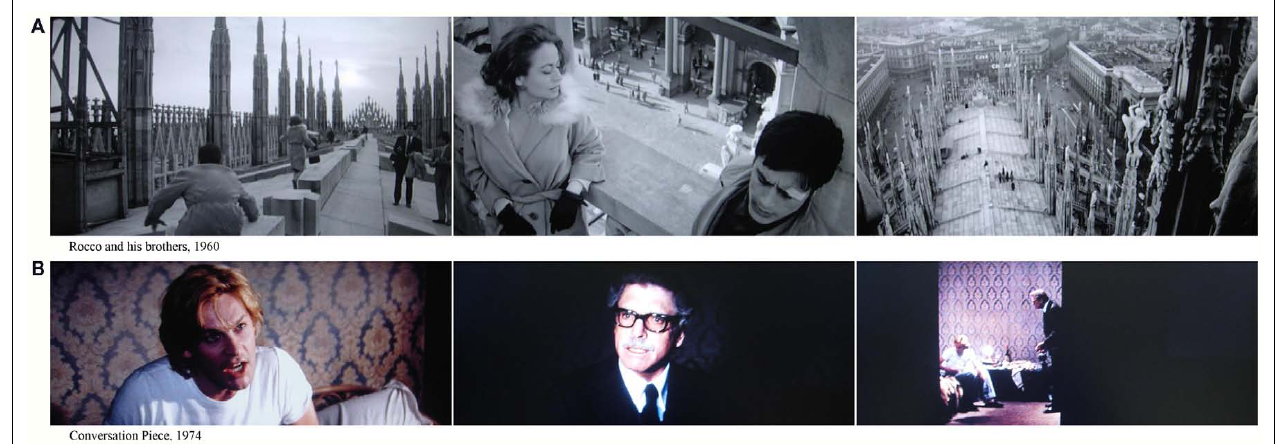
FIGURE 5 | LuchinoVisconti. (A) Scene from “Rocco and his brothers” on top of the Dome in Milan. (B) Scene with sequence of close-ups in “Conversation Piece.” © 2011, ProLitteris,